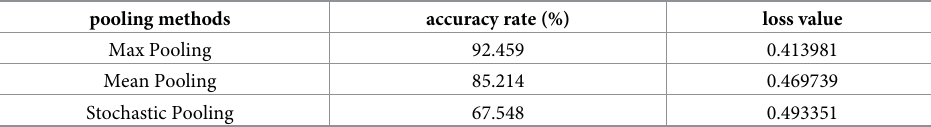
Table 5. The performance comparison of different pooling methods.